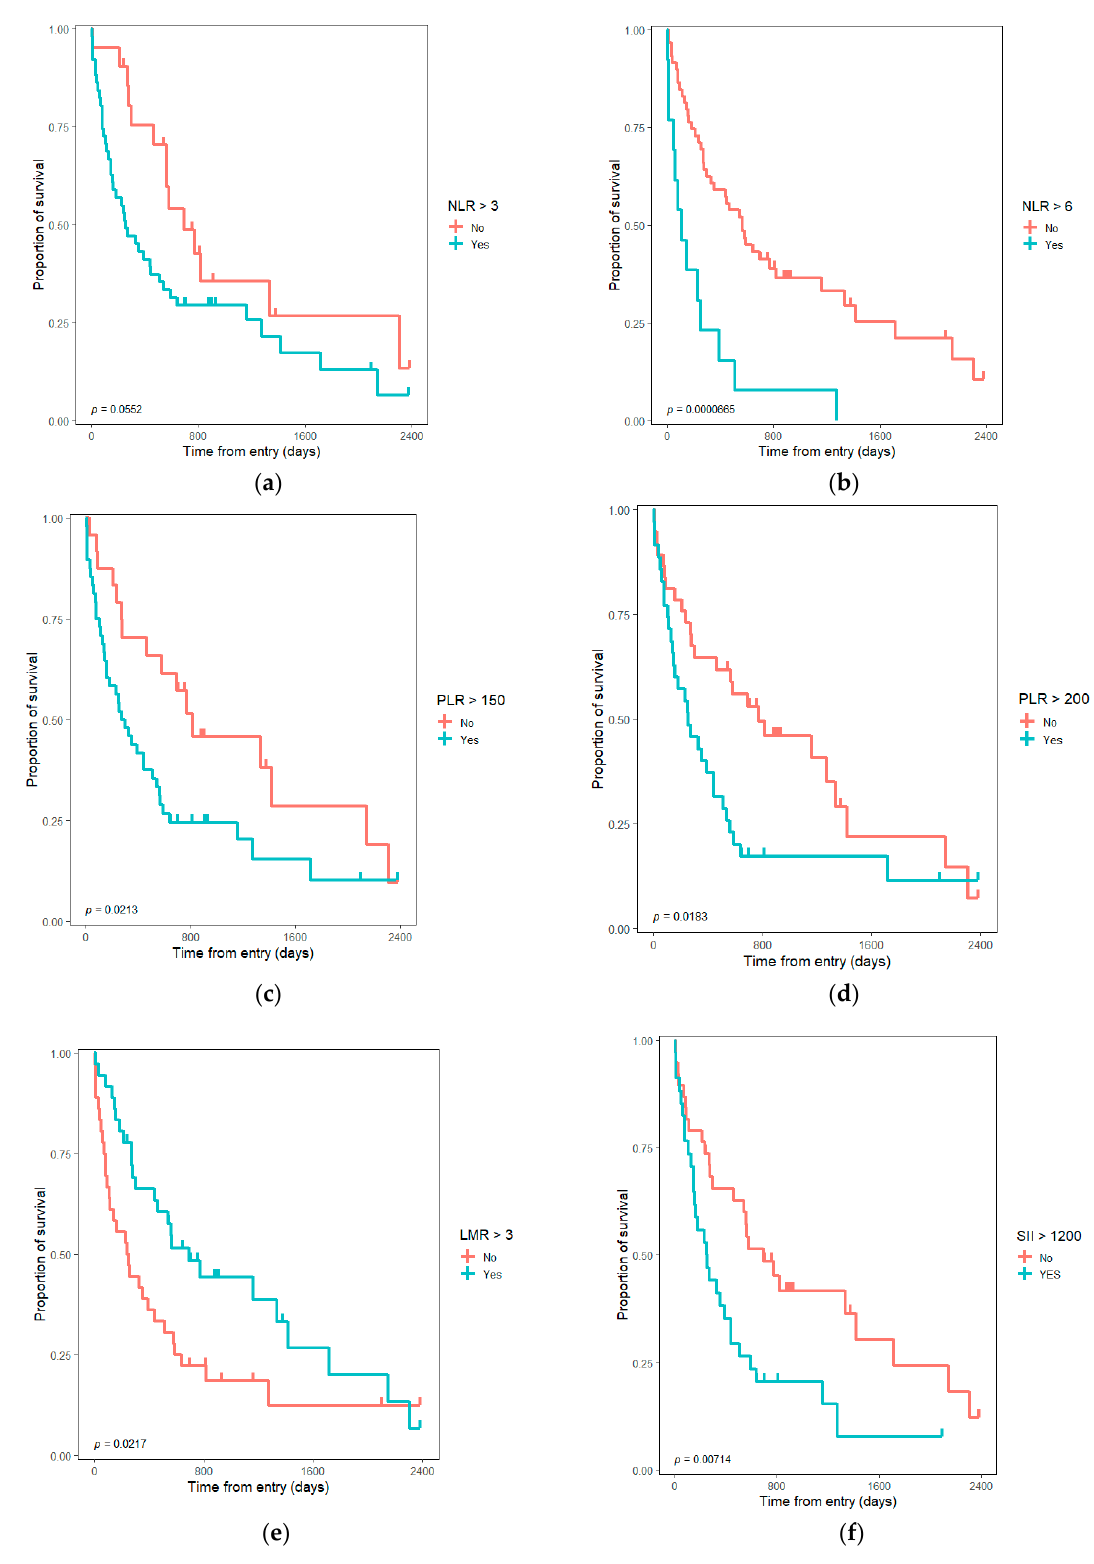
Figure 2. Kaplan–Meyer graph with survival differences for Klatskin tumors according to inflam- matory ratios cut-off values: ( a ) survival considering NLR > 3; ( b ) survival considering NLR > 6; ( c ) survival considering PLR > 150; ( d ) survival considering PLR > 200; ( e ) survival considering LMR > 3; ( f ) survival considering SII > 1200. NLR—neutrophil to lymphocyte ratio; PLR—platelet to lymphocyte ratio; LMR—lymphocyte to monocyte ratio; SII—systemic immune-inflammation